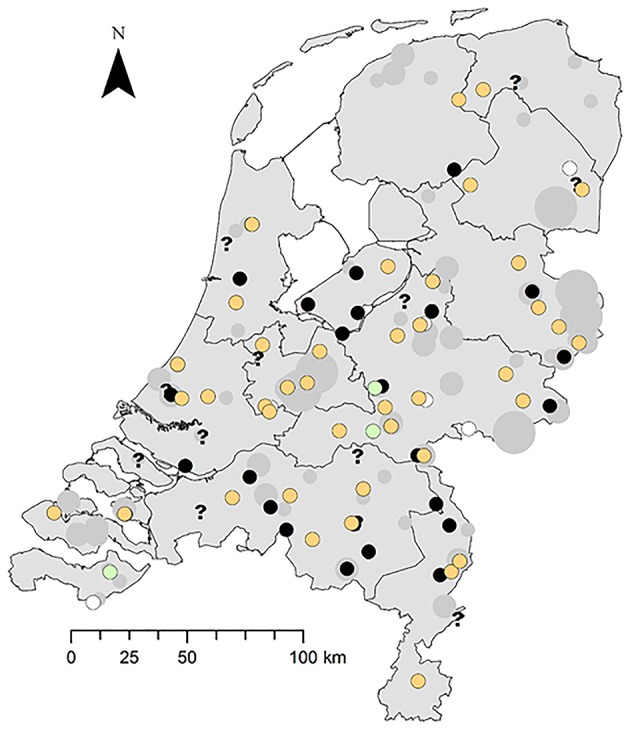
Spatial distribution of trichomonosis cases in the period 2009–2017 against the background of diseased greenfinches reported to Sovon. Trichomonad status: trichomonads subtype A1 present, orange circle; trichomonads subtype A1 with one substitution, green circle; trichomonads present, not genotyped, black circle; trichomonads absent, white circle; inconclusive, question mark. Number of diseased specimens reported to Sovon: 1, small gray dot; 2–10, middle-sized gray dot; >10 large gray dot.